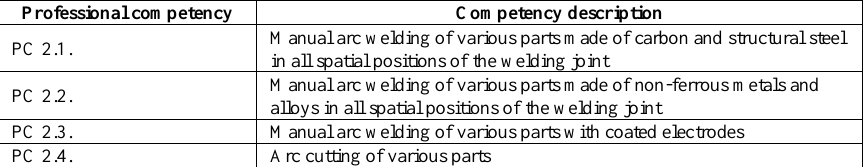
Table 2. Professional competencies (IDC